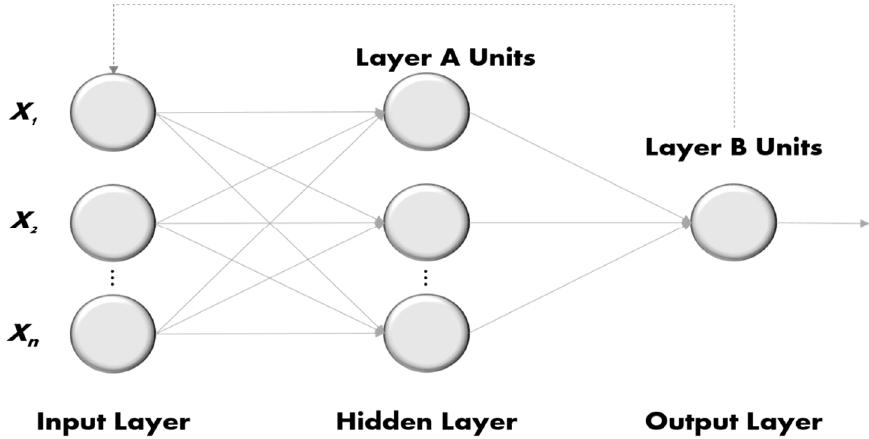
Figure 3. Artificial neural networks (ANN) design in this study.